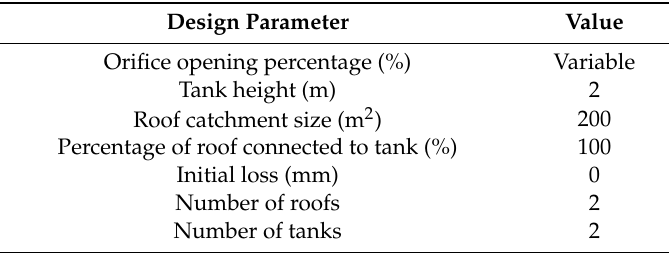
Table 1. Configuration of case study system.